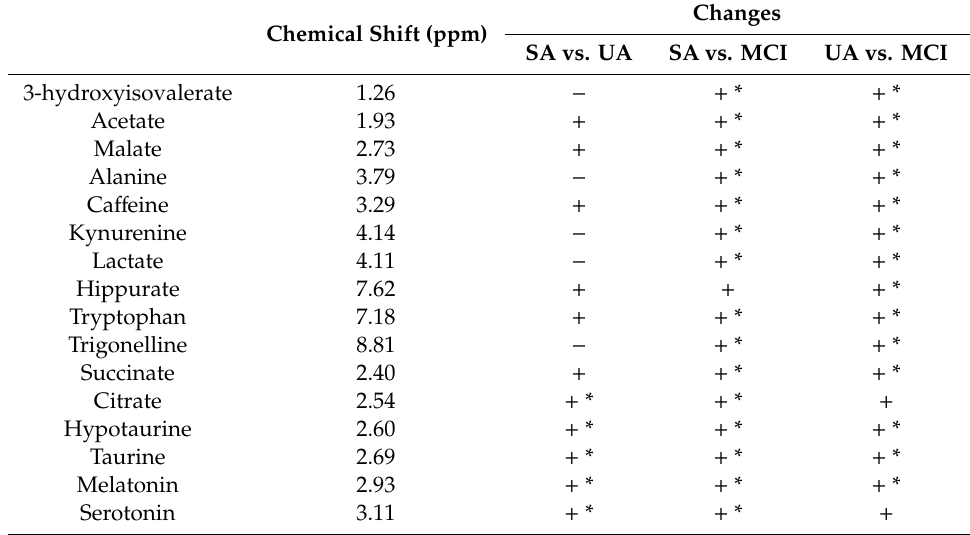
Table 3. Relative quantification of the discriminatory urinary metabolites identified from the PLS-DA analysis of the 1 H-NMR spectra aging groups, based on the mean peak area of the 1 H NMR